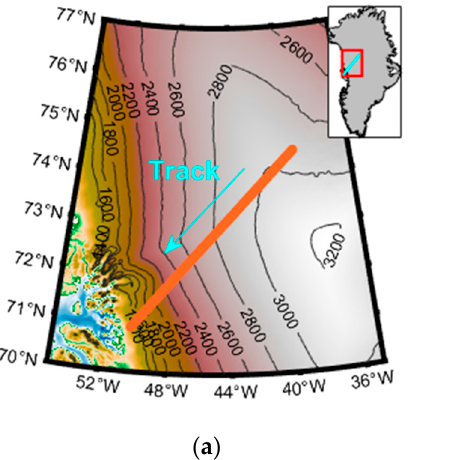
Figure 6. ( a ) Locations of the track over the DEM background in Greenland. ( b ) Elevations, surface slopes, and aspects at specular points. Those data are calculated based on the TanDEM-X 90 m elevation model.